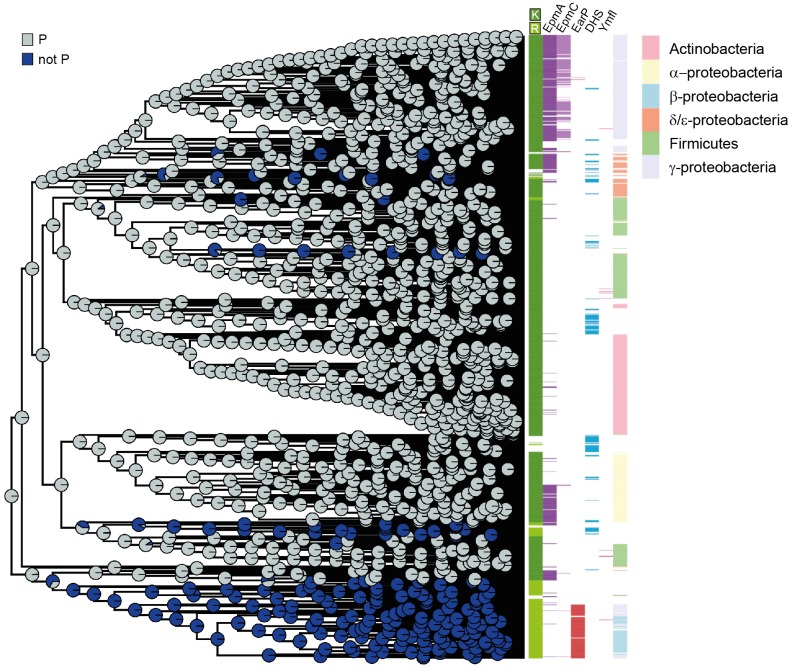
EF-P phylogeny and β3Ωβ4 sequence evolution (A) Phylogenetic tree reconstruction of the 32nd position (–2 relative to the β3Ωβ4 tip) of the EF-P KOW-like N-domain I. The colored circle areas correspond to the likelihood of the 32nd position to contain a proline (state “P”) or another amino acid residue (“not P”). (B) Bar colors indicate, from left to right, the amino acid located at the 34th position (β3Ωβ4 tip), the presence/absence of certain modification enzymes, and the taxonomy annotation for Proteobacteria, Firmicutes and Actinobacteria. Each colored line corresponds to one bacterial species in the EF-P data set (Supplementary Dataset S1).